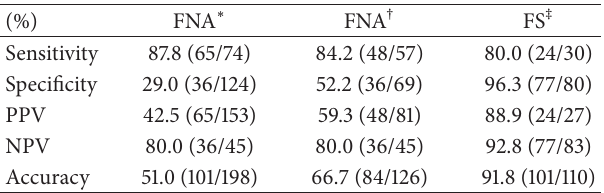
Table 4: Diagnostic performances of USFNA and intraoperative frozen section.